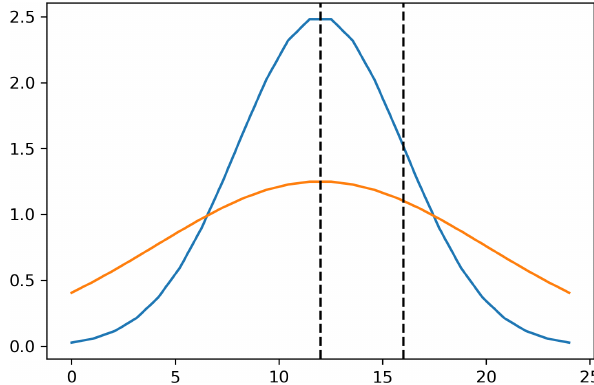
Figure 5. Schematic overview of two possible temporal profiles, which represent a different fraction of the total daily emissions dur- ing the selected period (12:00–16:00LT, illustrated by the dashed